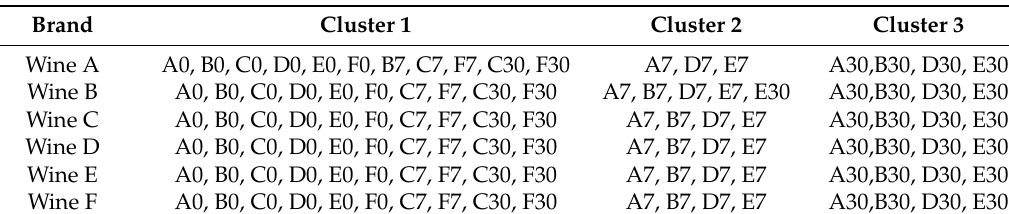
Table 3. Cluster content for all wine brands.